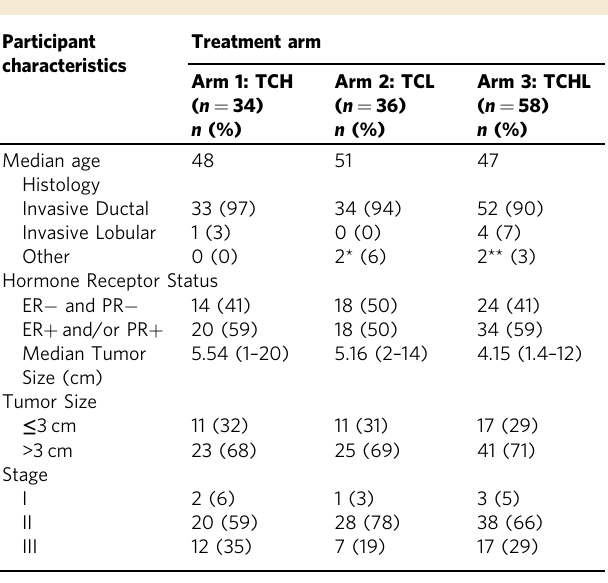
Fig. 1 TRIO-US B07 clinical trial participants. 130 participants were enrolled across three treatment arms. All participants received docetaxel plus carboplatin (TC) every 3 weeks. In addition, participants in Arm 1 received trastuzumab (TCH), Arm 2 received lapatinib (TCL), and Arm 3 received both trastuzumab and lapatinib (TCHL). Two participants withdrew from the study prior to starting any treatment, leaving 128 participants remaining in the intent to treat (ITT) population. Of 128 participants, 25 came off study treatment prior to surgery (10 in Arm 2, 15 Arm 3), leaving 103 participants included in the evaluable Table 1 Baseline characteristics.